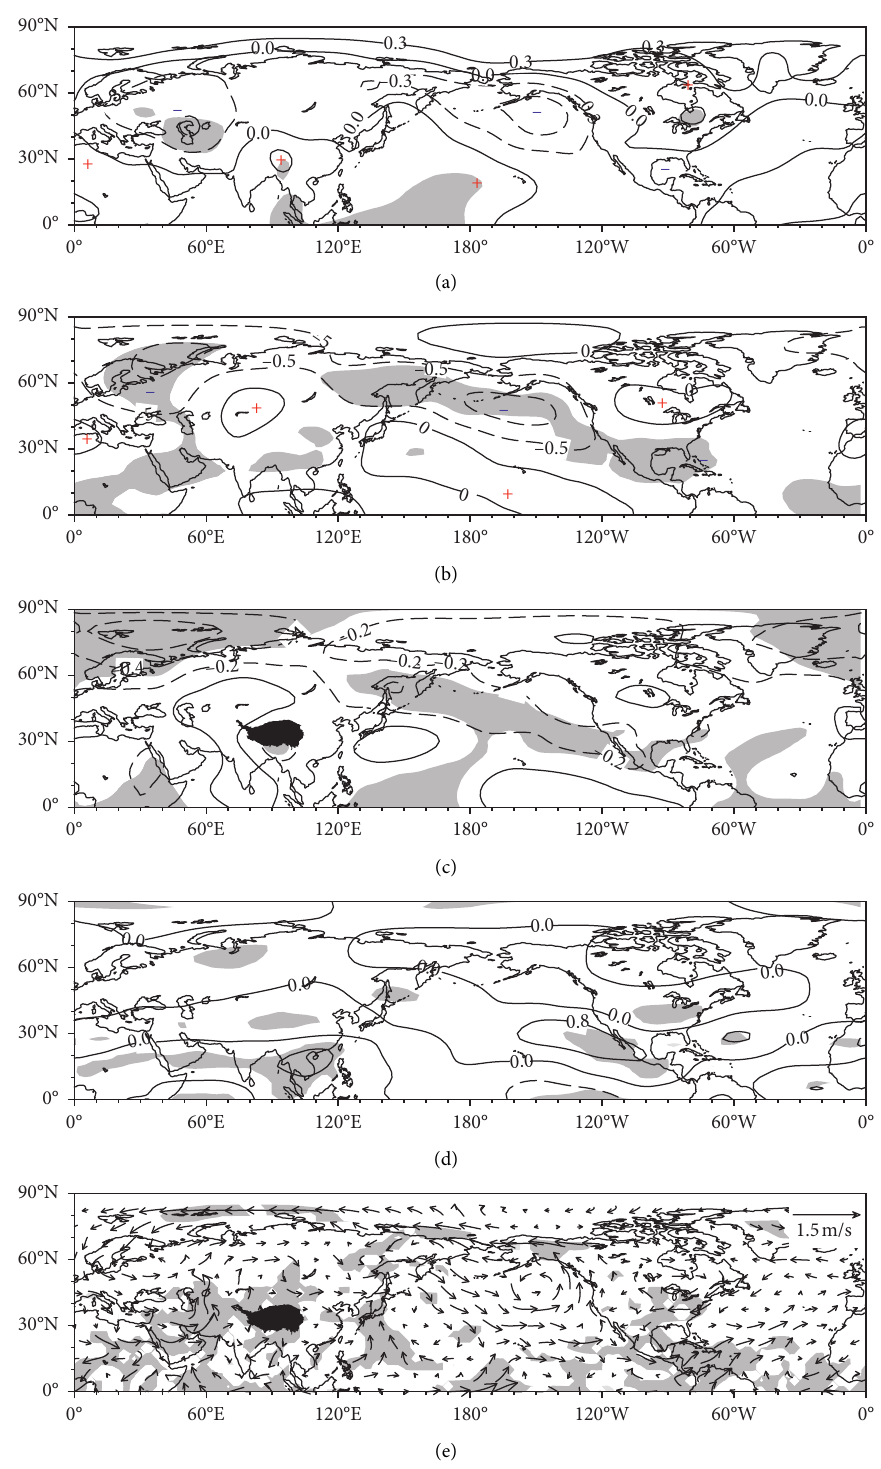
Figure 8: The same as in Figure 7 but for I